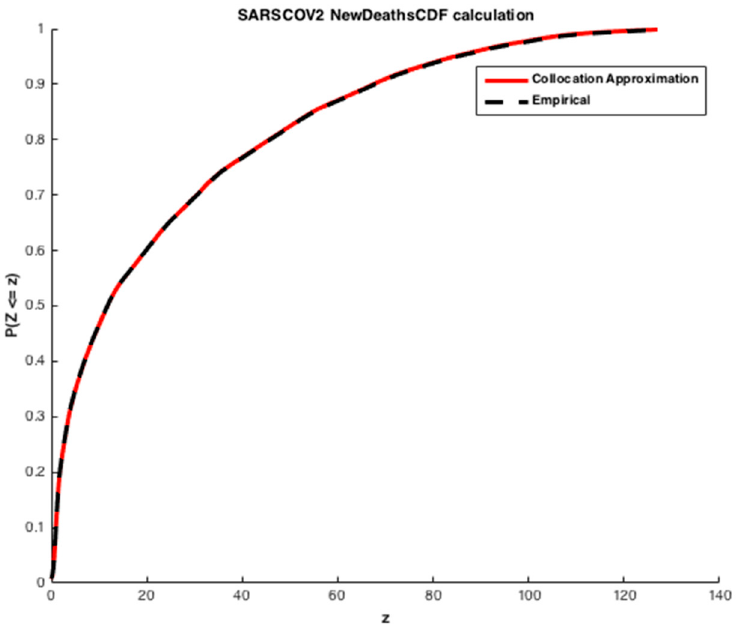
Figure 12. Estimation of the cumulative Density Function of the number of deaths by SARS-CoV-2 in Morocco. The results furnished by collocation.